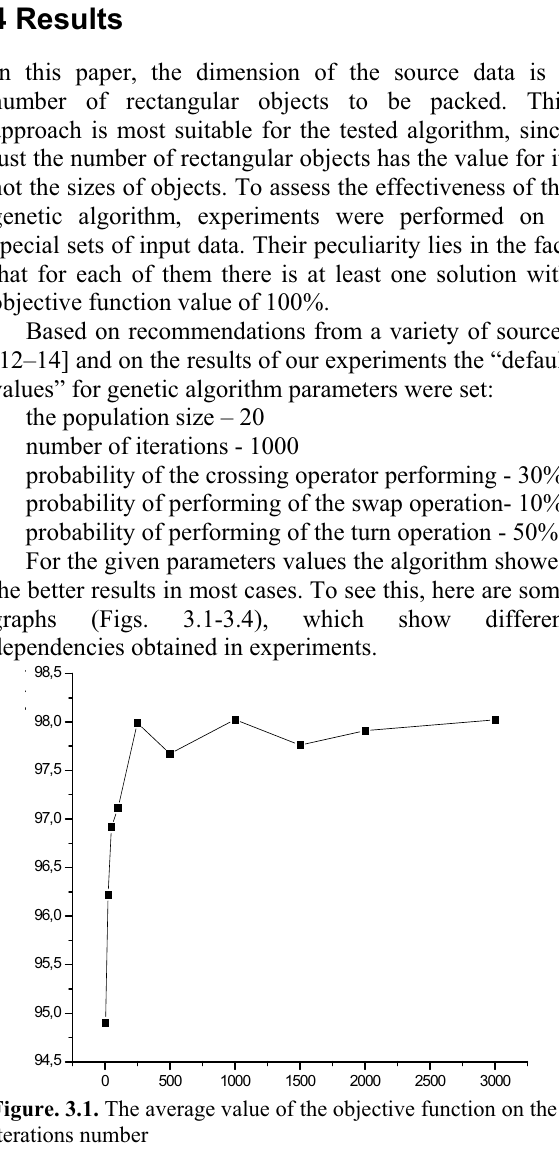
Figure. 3.1. The average value of the objective function on the iterations